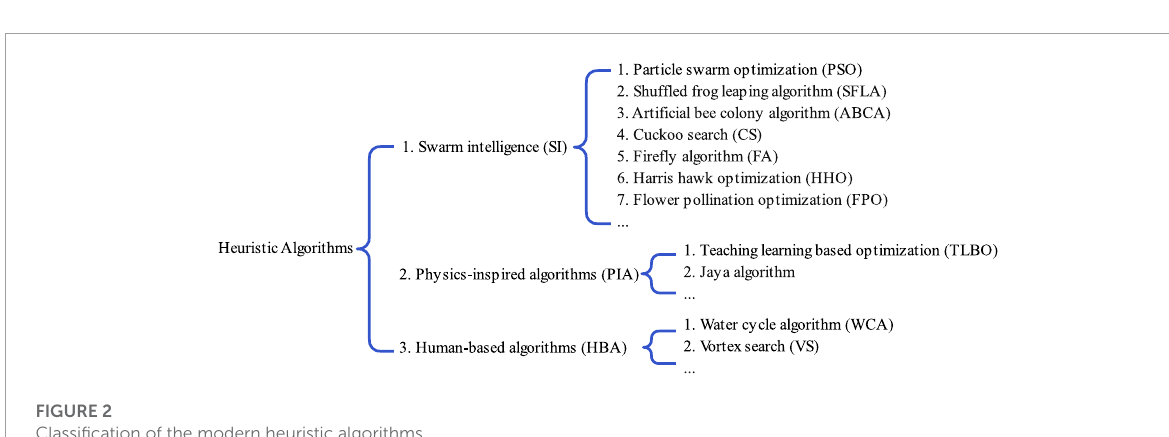
FIGURE 2 Classification of the modern heuristic algorithms.